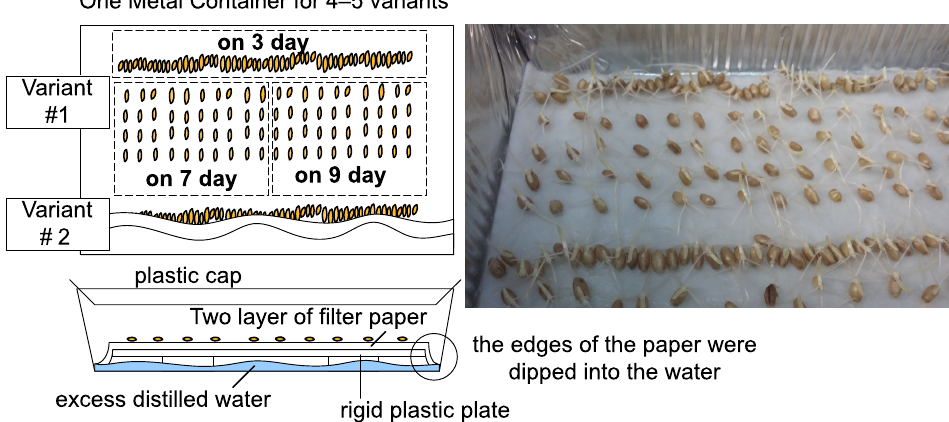
Figure 2. Seed germination layout in thermostat for determination of morphophysiological